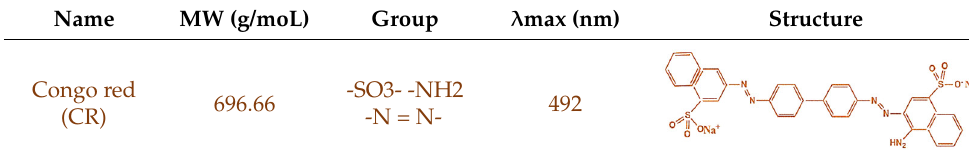
Table 1. The molecular structure and properties of Congo red.